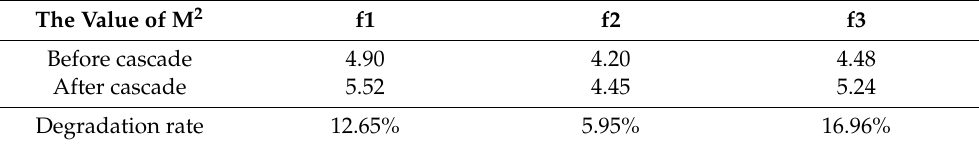
Figure 8. The diagram of testing performance and the beam quality of 3×1 fiber signal combiner. ( a ) The diagram of testing; ( b ) The beam quality of f1; ( c ) The beam quality of f2; ( d ) The beam quality of f3. Table 1. Comparison of beam quality before cascade and after